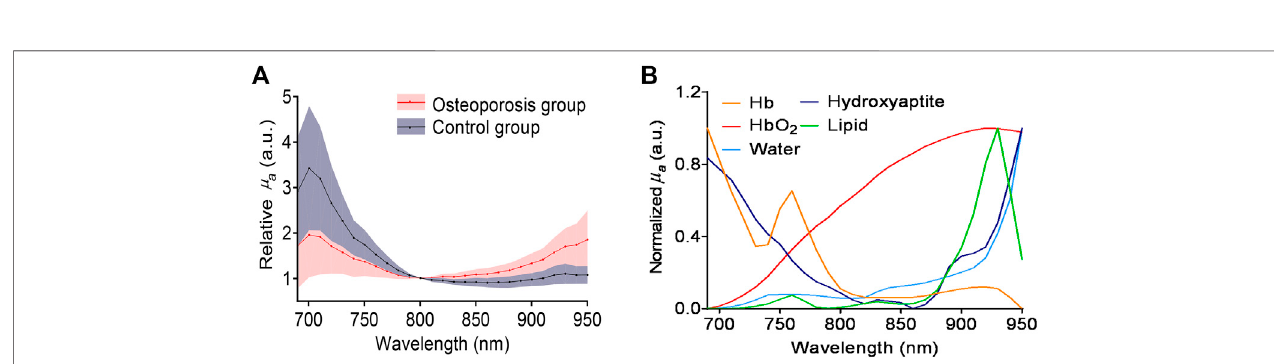
FIGURE4|(A) TheaveragedPAspectrameasuredfromtheosteoporosisgroupandcontrolgroup. (B) Opticalabsorptionspectraofmajorchemicalcomponents in the bone, including deoxygenated hemoglobin (Hb), lipids, hydroxyapatite, and oxygenated hemoglobin (HbO 2 ).